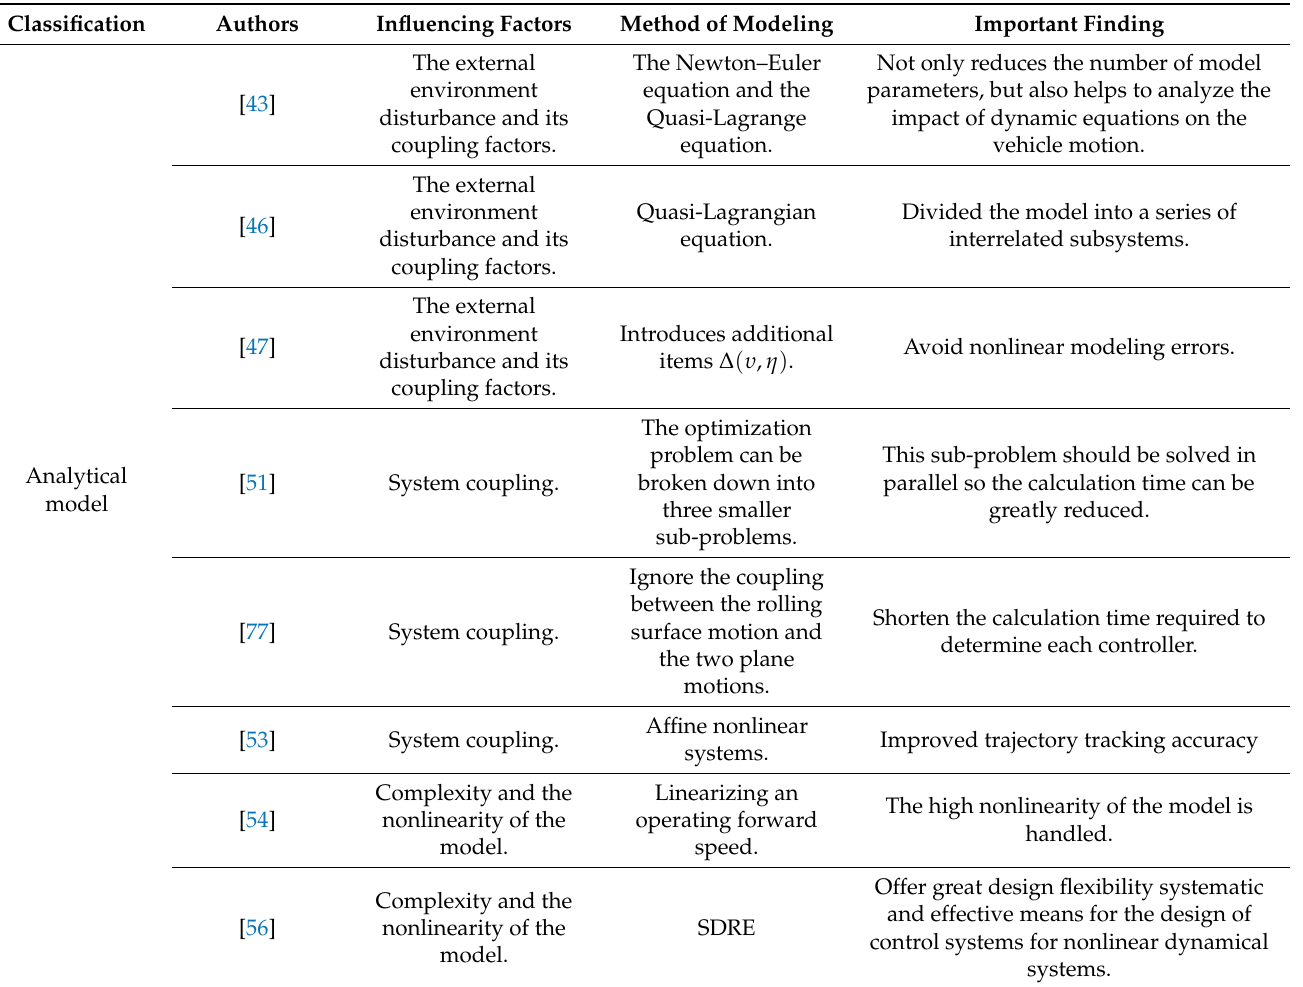
Table 2. Summary of the research studies on the modeling of AUV trajectory tracking